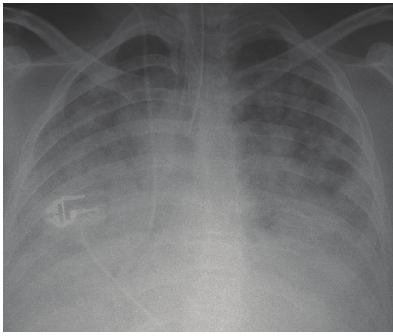
Figure 1: Postero anterior radiograph of the chest obtained after tracheal intubation on day 1.